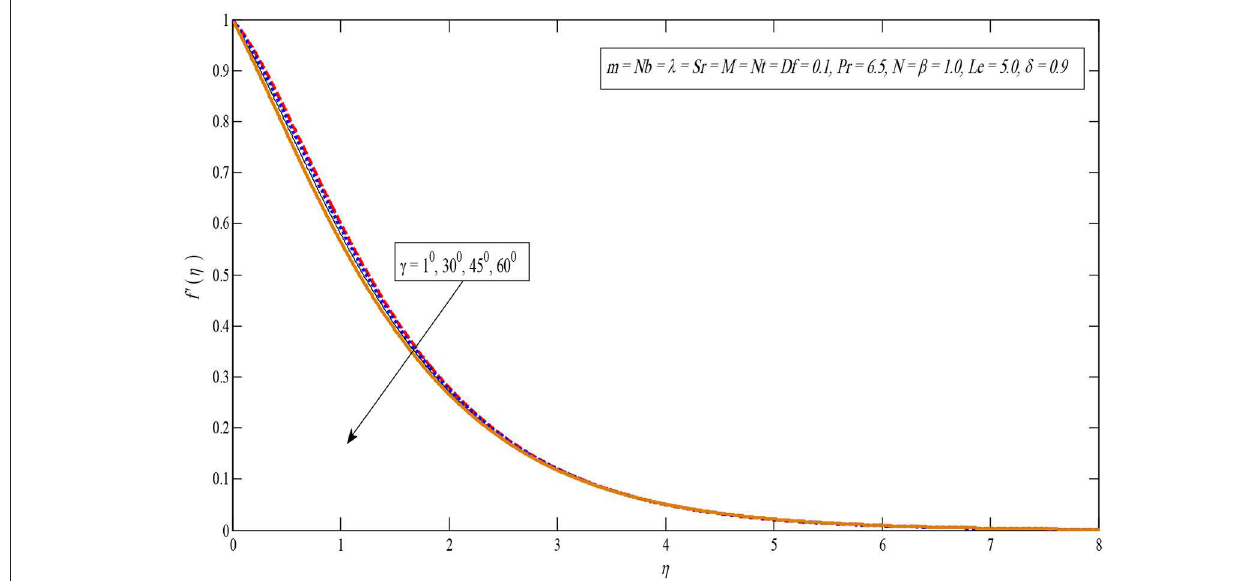
FIGURE 6 | Velocity profile for several values of γ .